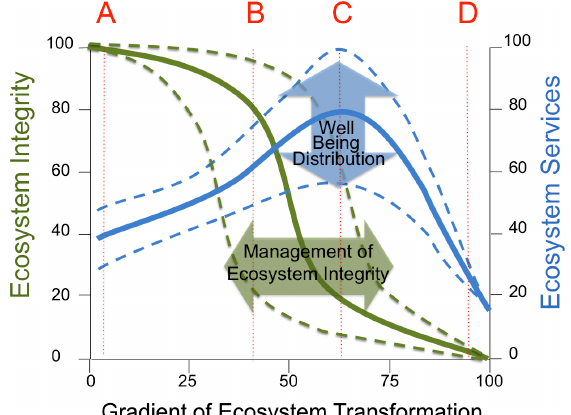
Fig. 1 . Relationship between ecosystem services, ecosystem transformation, and ecosystem integrity. See the text for an explanation and discussion of scenarios A, B, C, and